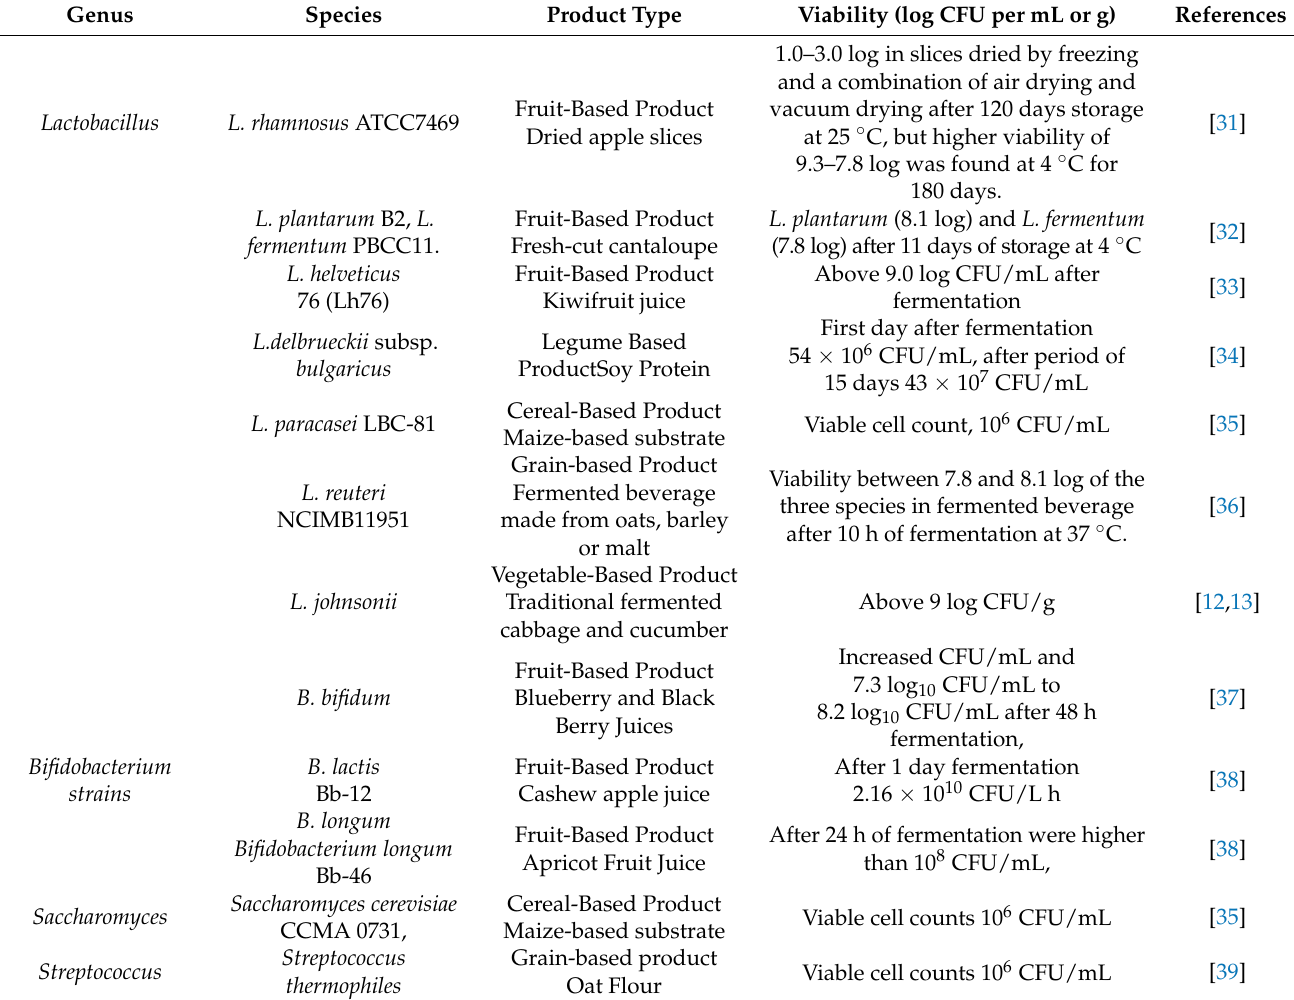
Table 1. Viability of probiotic bacteria in the different types of